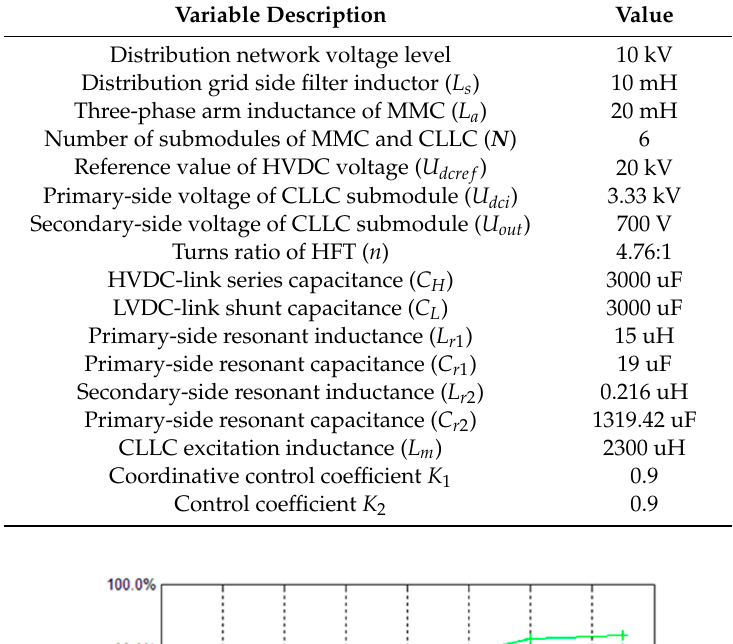
Table 2. The simulation parameters of the SST-based DC microgrid system.